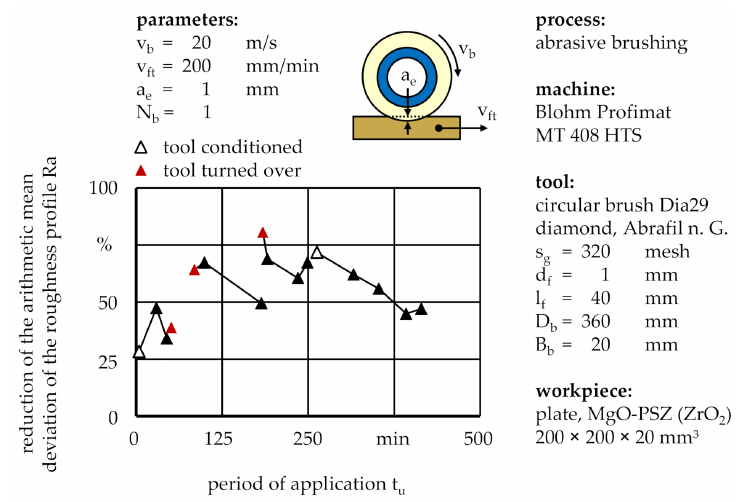
Figure 15. Deviating roughness reduction caused by the wear of the brushing